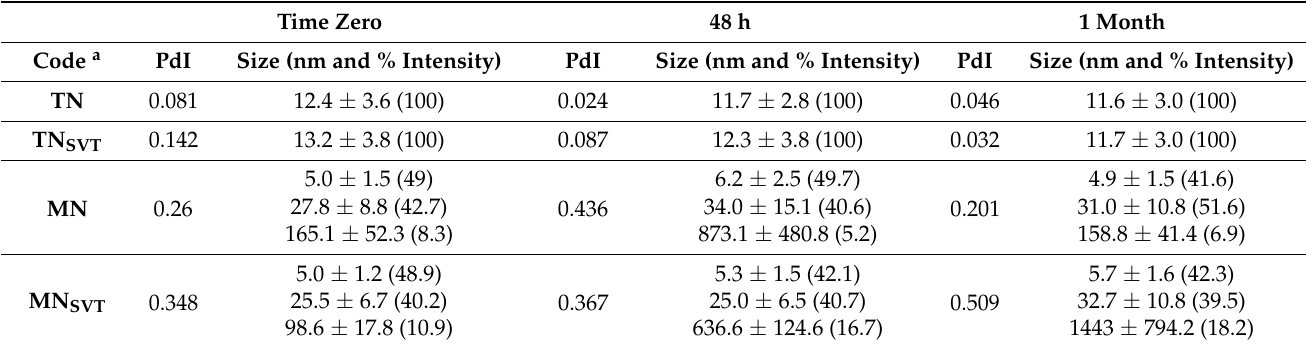
Table 1. Size distribution with relative populations weight by intensity of blank and SVT loaded micelles measured at time zero and after 48 h and 1-month storage at room temperature (SVT concentration 1 mg/mL). Time Zero 48 h 1 Month Code a